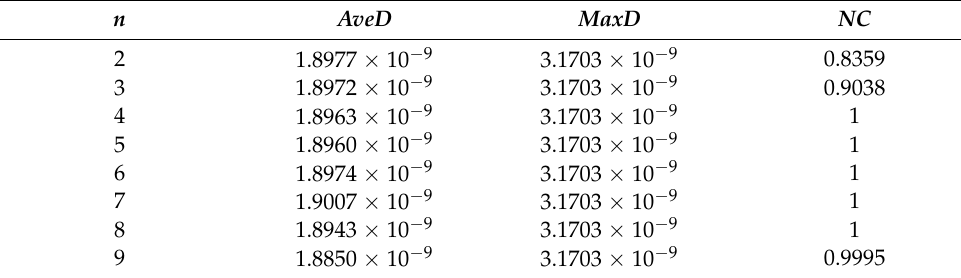
Table 5. The relationship between AveD , MaxD , NC and n ( R = 8 × 10 − 8 ).